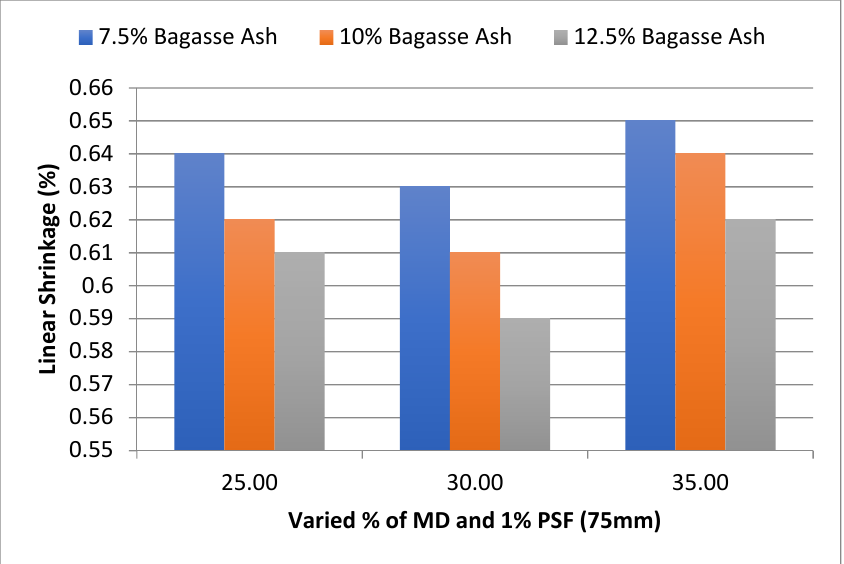
Figure 12. Effect of MD and BA on linear shrinkage of block reinforced with 1% PS fiber (75 mm).